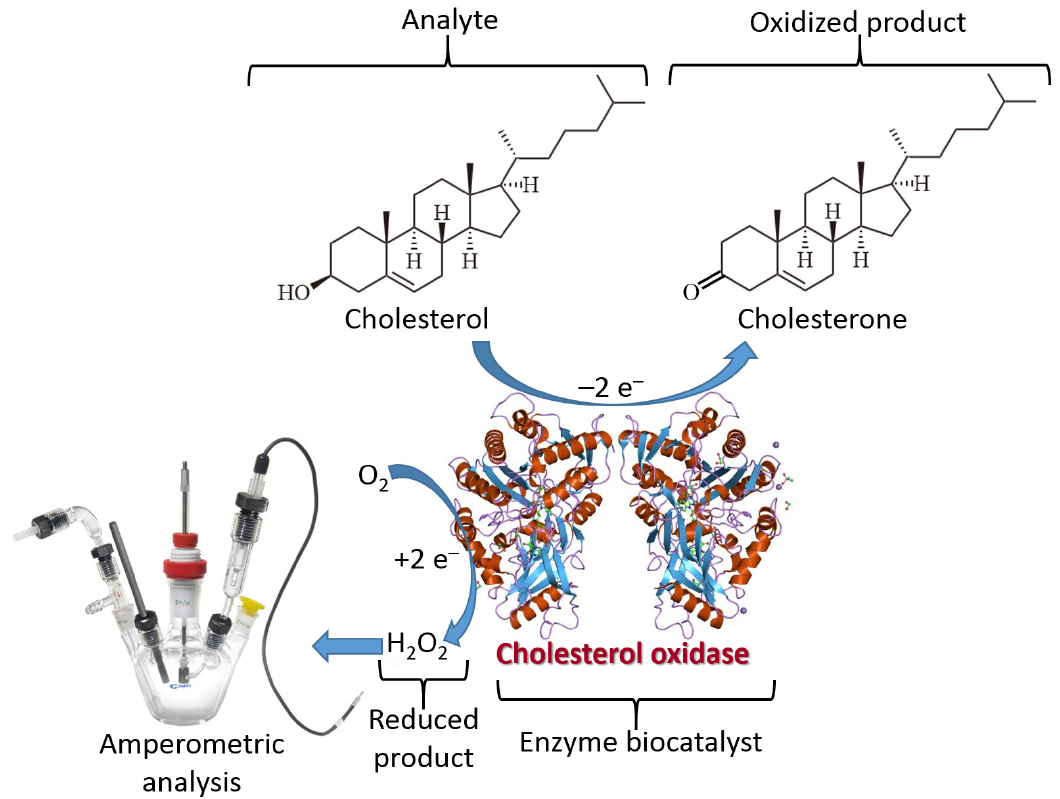
Figure 3. Enzyme-catalyzed reactions can be used for the transformation of a substrate-analyte signal Figure 3. Enzyme ‐ catalyzed reactions can be used for the transformation of a substrate ‐ analyte sig ‐ into an electronic signal. The scheme shows an example of such enzyme-based signal nal into an electronic signal. The scheme shows an example of such enzyme ‐ based signal transduc ‐ tion using cholesterol oxidase for the analysis of cholesterol. A side H 2 O 2 product is detected elec ‐ trochemically, e.g., by amperometric technique. While the measurements are based on the analysis of H 2 O 2 , its concentration is stoichiometrically related to the cholesterol concentration in the ana ‐ lyzed sample. Notably, another approach can be based on an analysis of the O 2 depletion instead of the H 2 O 2 production.